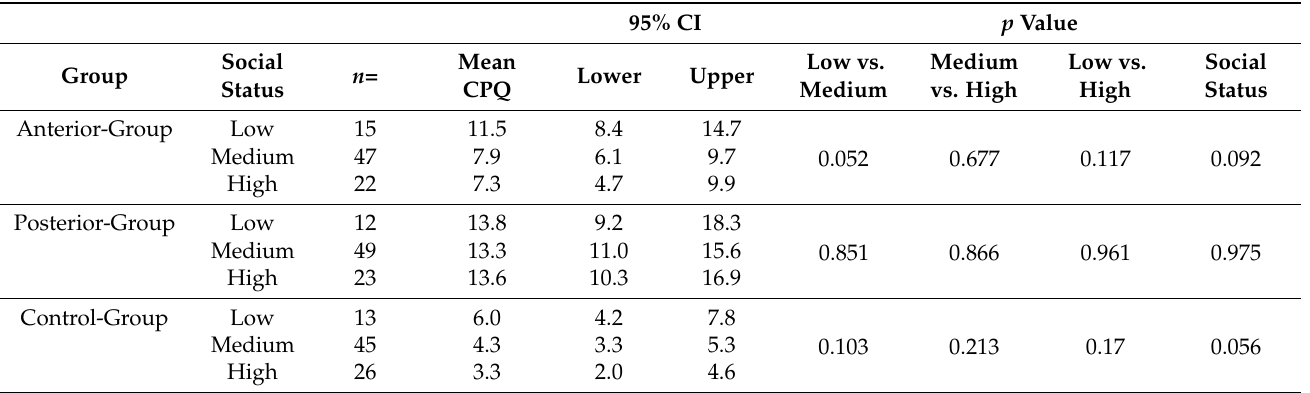
Table A7. Means and Confidence Intervals for the Total-CPQ-Scores differentiated by their social